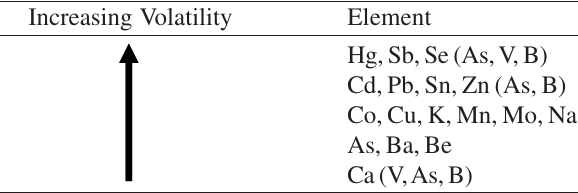
Table 4 . Predicted volatility of trace and alkali metals in gasification gases